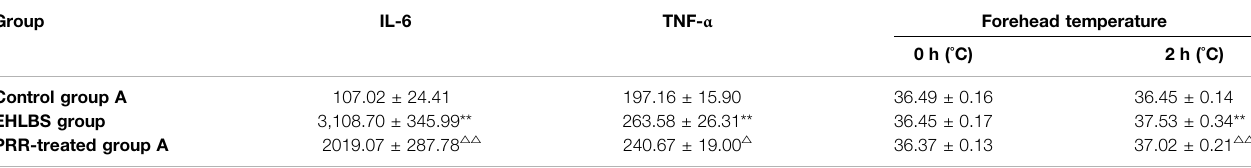
TABLE 1 | Comparison of in fl ammatory indices among different groups of the rats in EHLBS stage ( ‾ x ± s, n = 10). Group